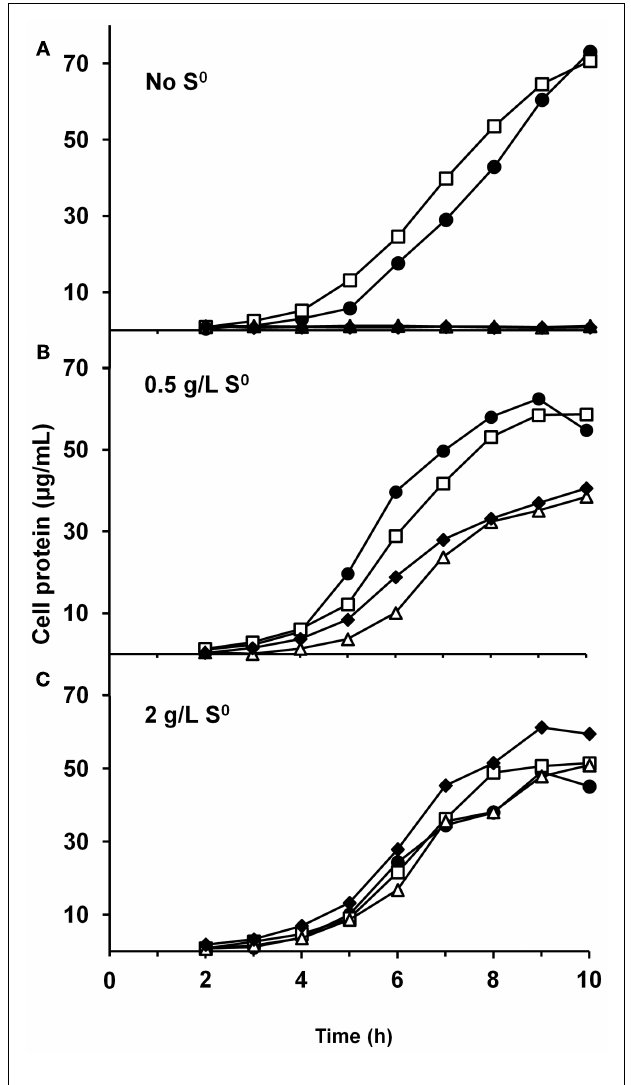
FIGURE 2 | Growth characteristics of P. furiosus strains grown in maltose-based medium (A), supplemented with 0.5g/L S 0 (B), and supplemented with 2g/L S 0 (C). The symbols represent: closed circles, COM1c; open squares, Δ SHI Δ SHII; open triangles, Δ mbhL; closed diamonds, Δ SHI Δ SHII Δ